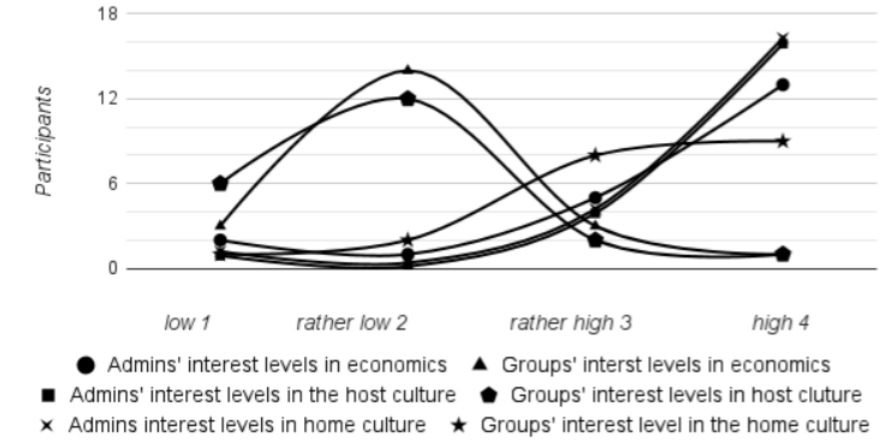
Figure 4. Group dynamics and interest levels in politics and the assimilation vs integration debates.